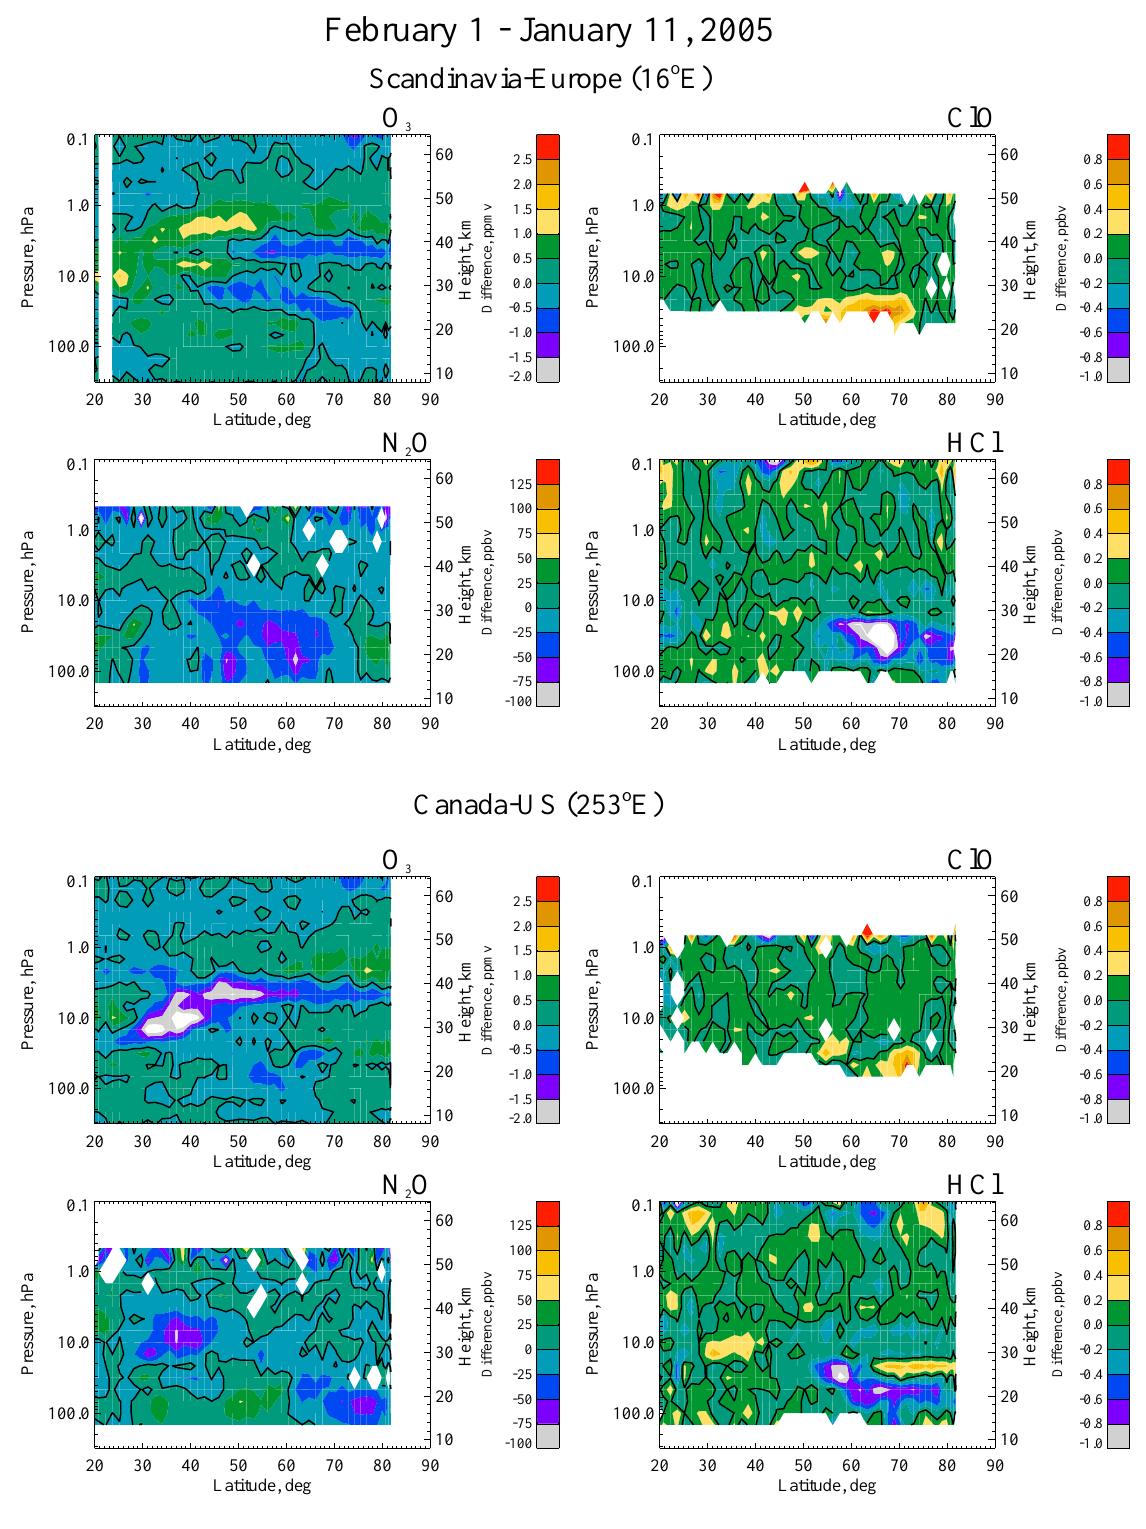
Fig. 7. Contour plots for the temporal differences (1 February minus 11 January) in mixing ratios of four chemicals (Aura MLS), at the chosen longitudinal sectors through Svalbard-Tromso-Collm (16 ◦ ± 12.5 ◦ E) and Saskatoon-Platteville (253 ± 12.5 ◦